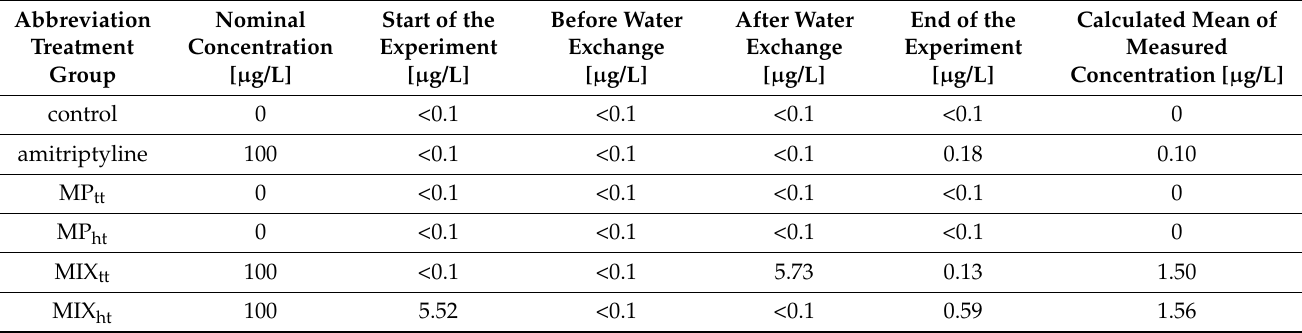
Table 2. Measured amitriptyline concentrations of the second experiment (limit of quantification (LoQ) 0.1 µ g/L; for calculation of mean exposure concentrations values below the limit of quantifi- √ cation were substituted with LoQ/ 2; MP tt : 10 4 particles/L PS MP; MP ht : 10 5 particles/L PS